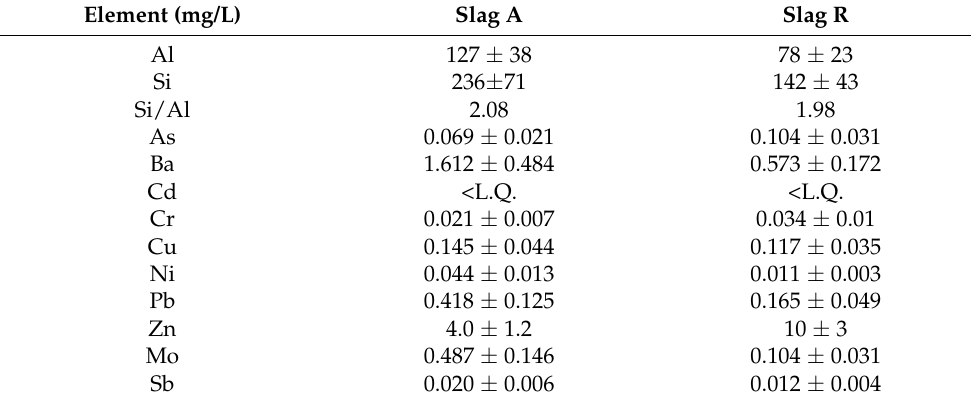
Table 4. ICP-OES determination of the soluble Si and Al atoms, heavy metals, and amphoteric elements in NaOH 8M solution, at 80 ◦